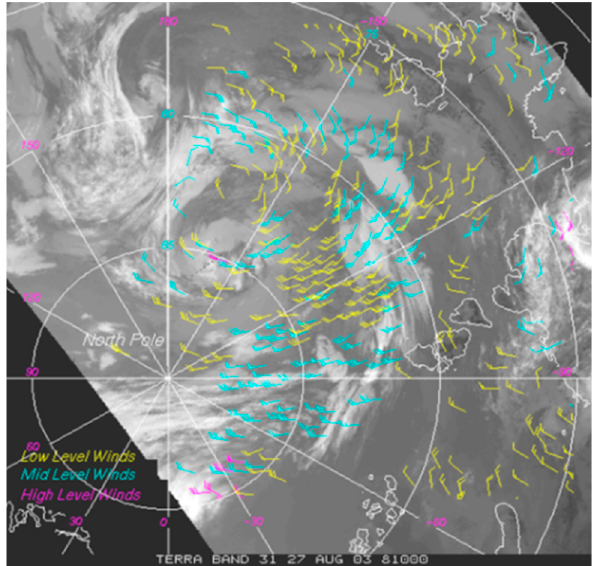
Figure 2. Motion vector winds from MODIS, which observes portions of the polar region approximately every 100 minutes. Wind tracers are identified using automated algorithms that identify trackable features from a sequence of images. The positions and direction are indicated by wind-barbs, with flags encoded for speed. Color indicates approximate altitude of the AMV.